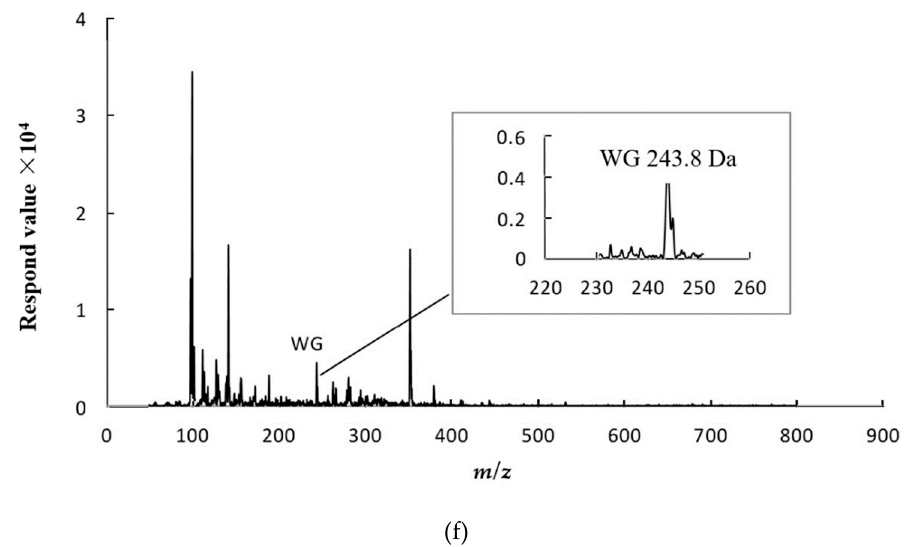
Figure 2. Liquid chromatography–mass spectrometry (LC-MS) spectrogram of peptide fragments of WGAPSL after simulated gastrointestinal digestion. ( a ) Intact WGAPSL; ( b ) fragment APSL; ( c ) fragment PSL; ( d ) fragment W and GAPSL; ( e ) fragment WGA; ( f ) fragment WG.